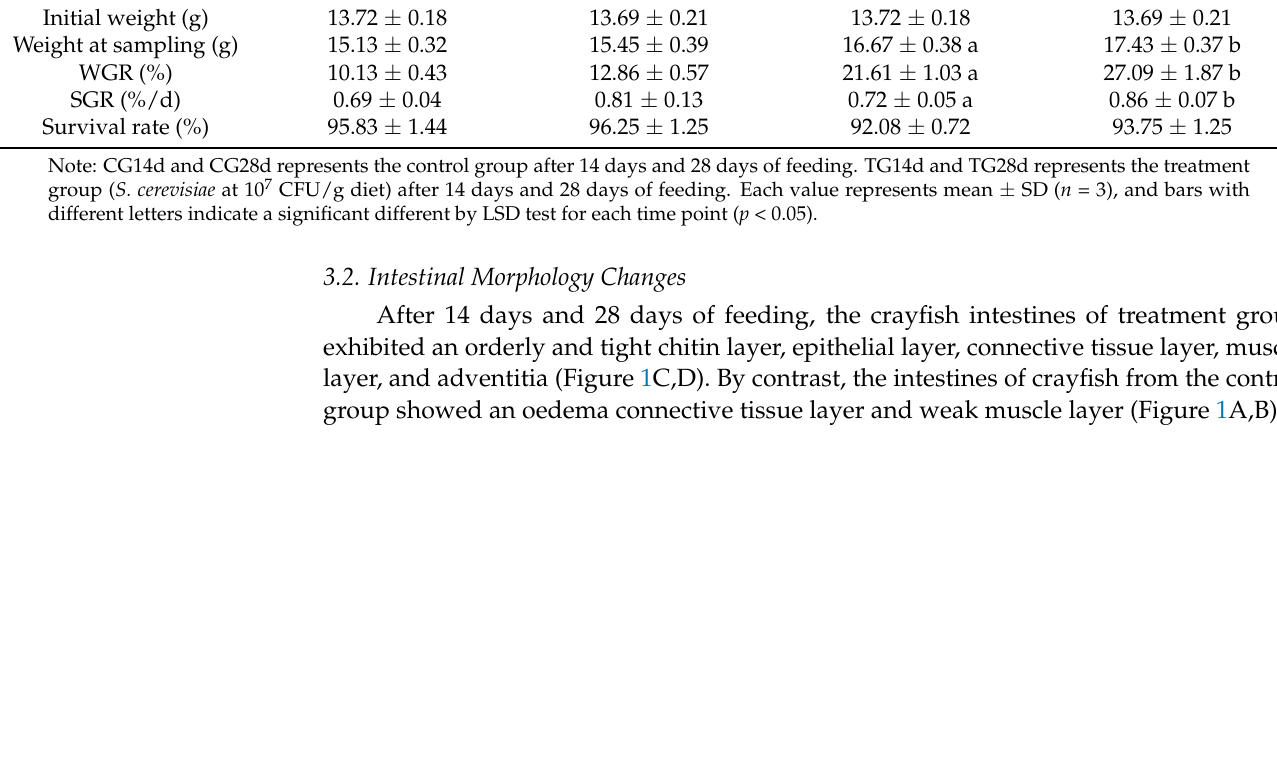
Table 2. Growth performance of crawfish fed with different experimental diets for 14 and 28 days.